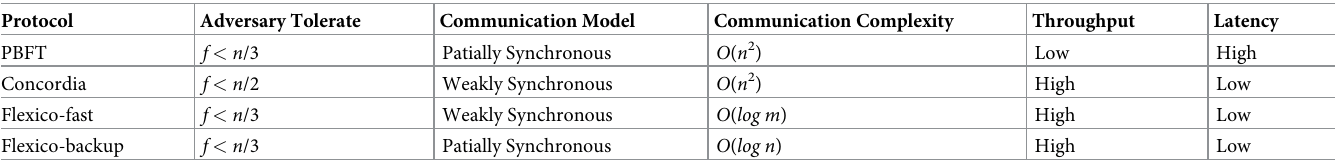
Table 3. Flexico and its predecessor consensus